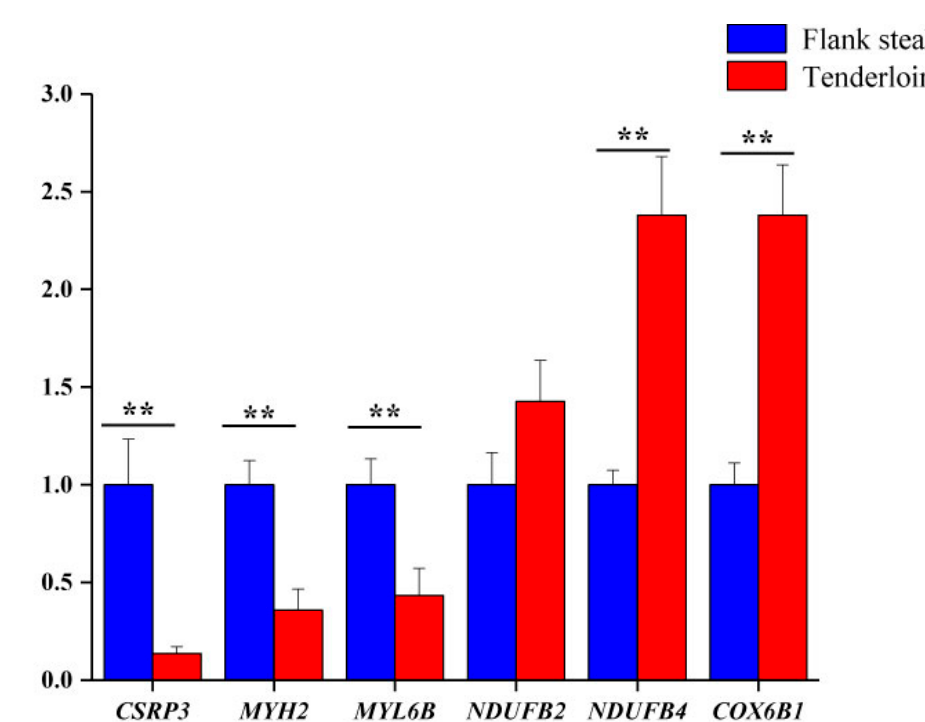
Figure 2. Validation of the gene corresponding to the differentially expressed proteins by quantitative real-time reverse transcription PCR (qRT-PCR). ** very significant differences between the tenderloin steaks and the flank steaks ( p < 0.01).